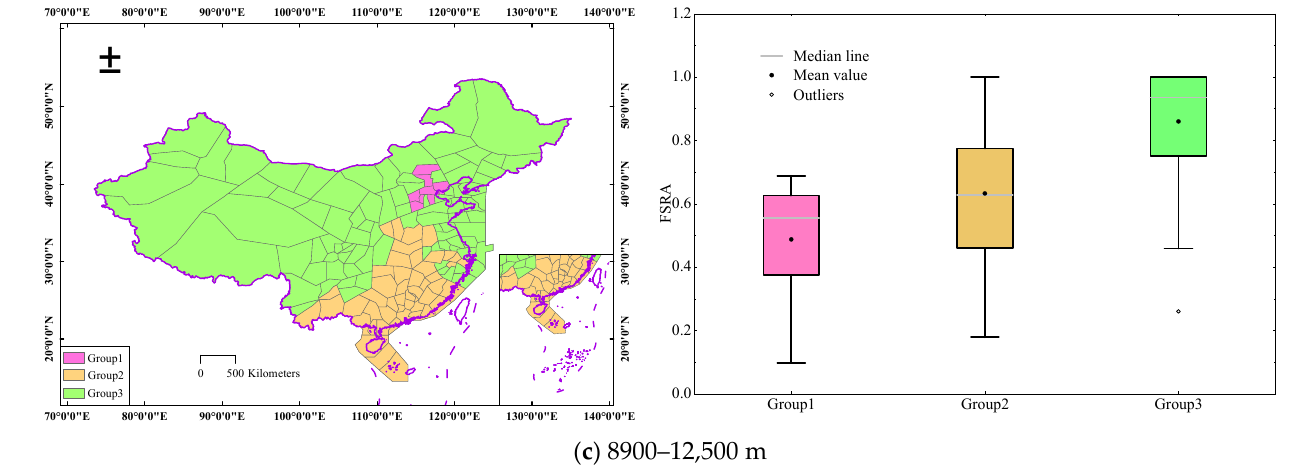
Figure 10. Spatial clustering result of FSRA in Chinese airspace. altitude ranges seems similar, the FSRA values in each group at various altitude ranges are unique. In the altitude range from 6000 to 7800 m, Group1 corresponded to the second lowest FSRA value, with a mean value of 0.5418. Group2 reflected the lowest FSRA value, with a mean value of 0.4438, and Group3 represented the highest FSRA value, with a mean value of 0.8634. However, in the altitude ranges from 7800 to 8900 m and from 8900 to 12,500 m, Group1 responded to the lowest FSRA value with mean values of 0.5606 and 0.4875, respectively; Group2 demonstrated the second lowest FSRA value, with mean values of 0.5908 and 0.6326, respectively; Group3 had the highest FSRA value with mean values of 0.8805 and 0.8721,